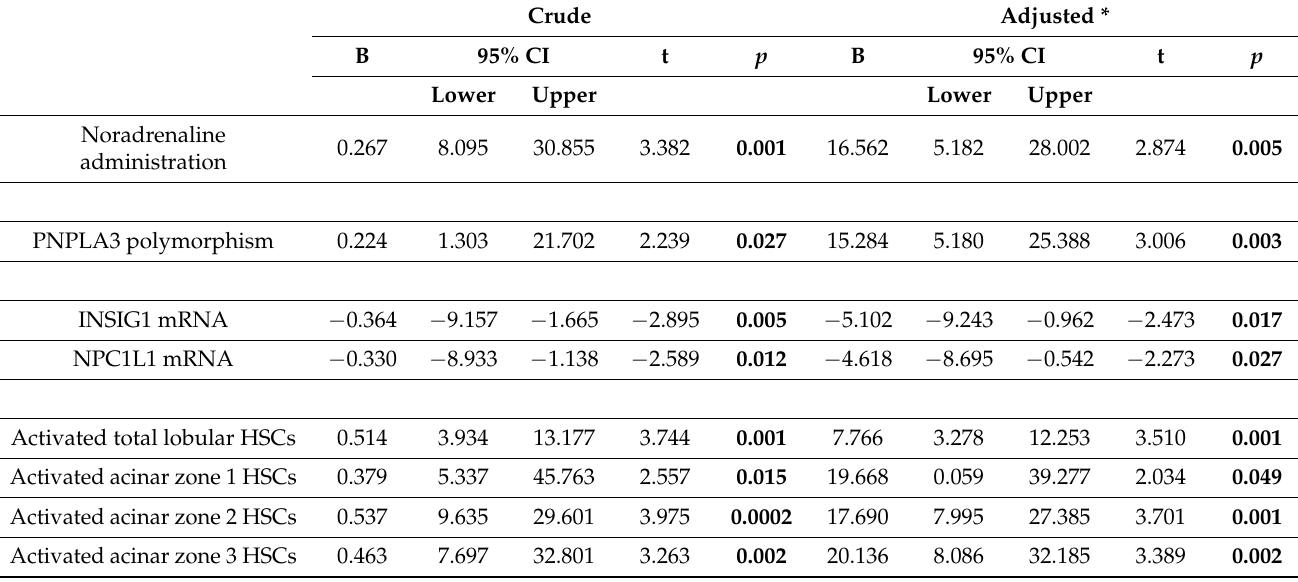
Table 3. Crude and adjusted linear regression models of variables significantly associated with the percentage of steatotic hepatocytes containing Ld-MaS. Crude Adjusted * B 95% CI t p B 95%